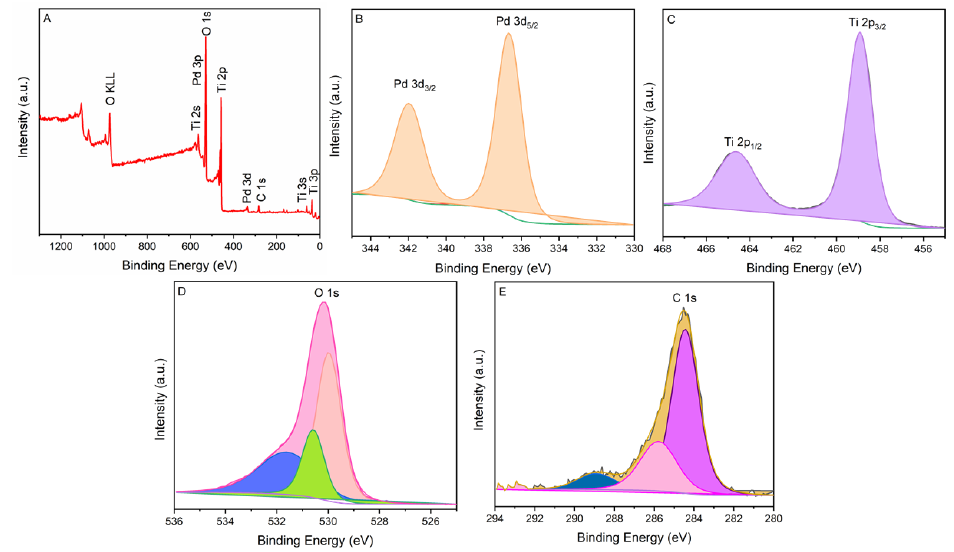
Figure 4. High resolution XPS spectra of the PdO.TiO 2 : ( A ) survey scan; ( B ) Pd 3d 5/2 and Pd 3d 3/2 states; ( C ) Ti 2p 1/2 and Ti 2p 3/2 ; ( D ) O 1s; ( E ) C1s reference peak.